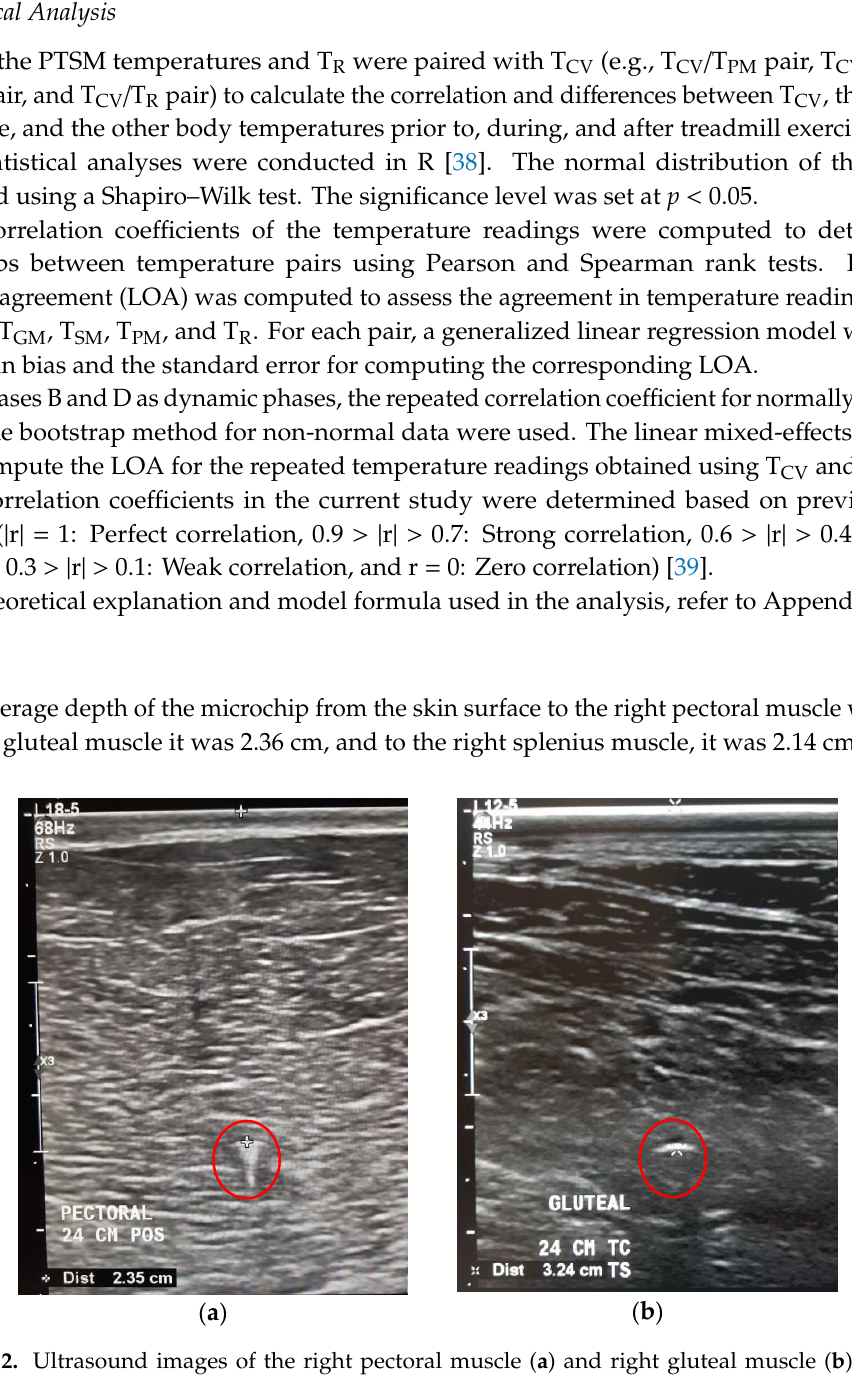
Figure 1. Exercise program by phases and body temperature acquisition points.